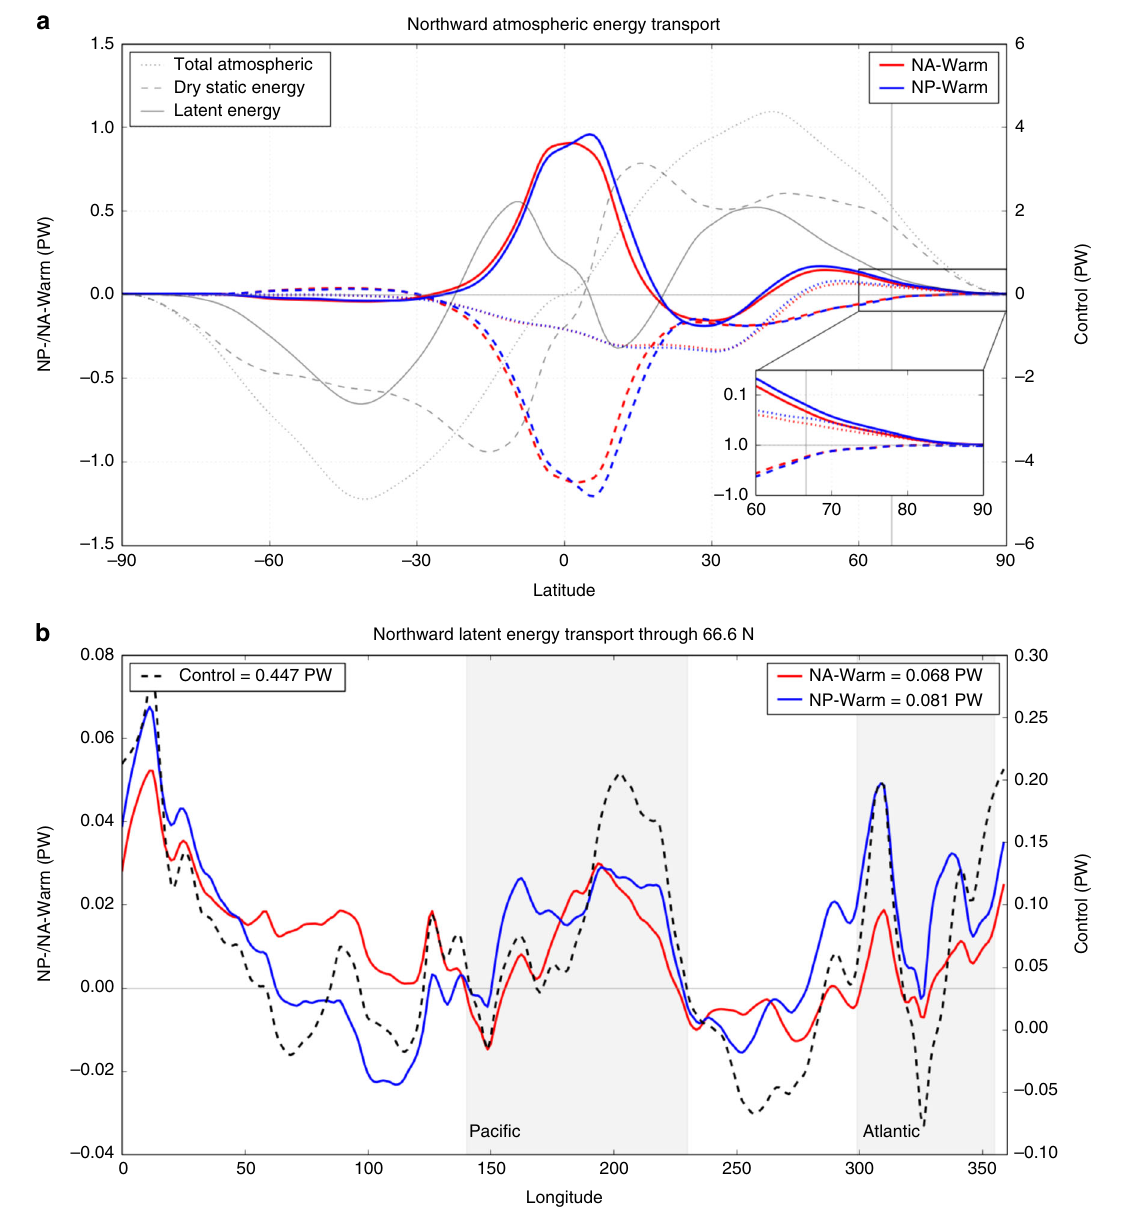
Fig. 5 Decompositions of atmospheric energy transport. The total atmospheric energy transport across latitude, decomposed into dry static energy (sensible heat and geopotential energy terms) and moist (latent heat term) energy ( a ). Control values are in gray (as absolute values), NA-Warm anomalies relative to the control are in red, and NP-Warm anomalies are in blue. Inset shows a blow-up of the difference in the two cases from 60 to 90°N. The increase in latent heat transport dominates the total change in northward atmospheric energy transport, and is greater in the NP-Warm case relative to the NA-Warm case. b A zonal decomposition of the northward latent heat transport across the Arctic boundary (66.6°N), depicting the longitudinal distribution of the change in latent heat transport (i.e., moisture intrusions), with the Paci fi c and Atlantic basins shaded in light gray for reference. The values in the upper right corner depict the total latent heat transfer (integrated throughout the atmosphere) across the Arctic boundary. Control values are the dashed line (as absolute values), whereas the NA-Warm anomalies are in red, and NP-Warm anomalies are in